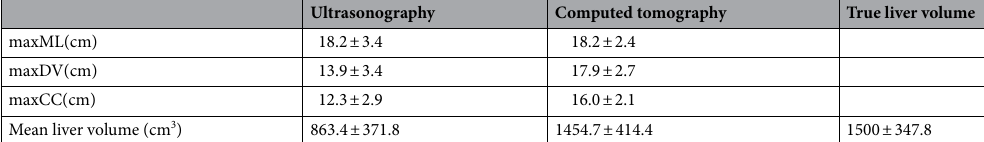
Table 1. Mean and standard deviations of maximum diameters measured in ultrasound, computed tomography and true liver volume extracted from manual liver